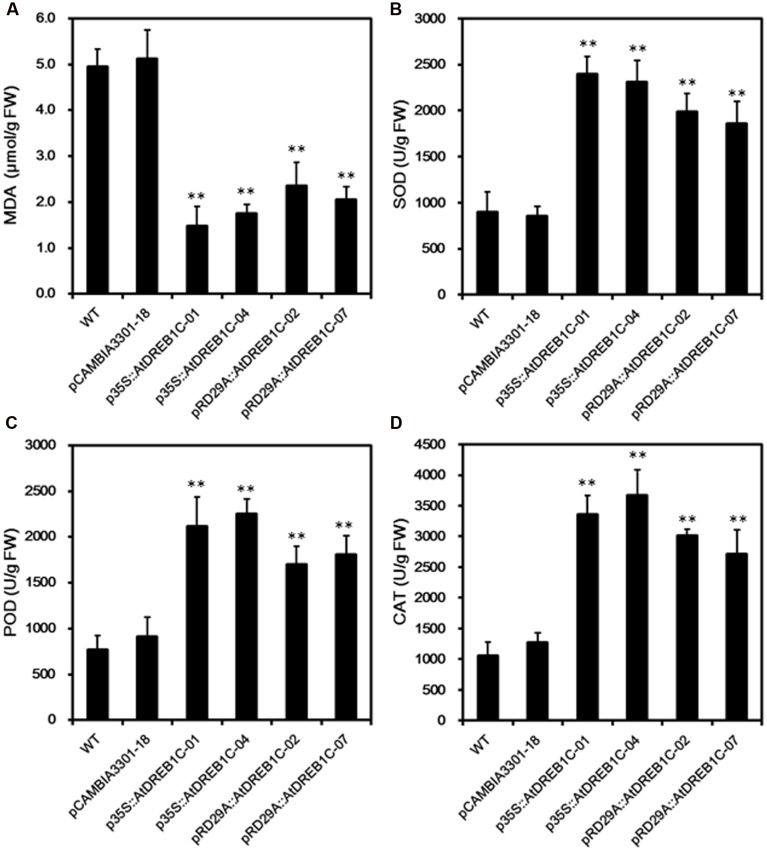
Malondialdehyde levels (A) and SOD (B), POD (C), and CAT (D) activity in WT and transgenic S. miltiorrhiza plants after withholding watering for 9 days. WT, wild type. The transgenic lines are indicated by the construct names followed by the line number: p35S::AtDREB1C-01 refers to p35S::AtDREB1C line 01 and so on; pCAMBIA3301-18 was used for the positive control. Bars represents the mean + SE of three independent experiments. ∗∗Significantly different at the P < 0.01 level compared to WT.